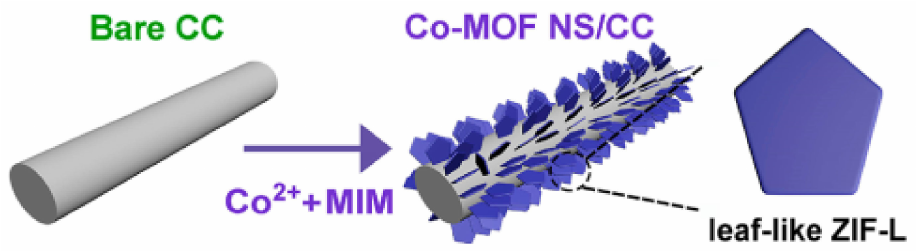
Figure 17. Schematic illustration for the fabrication of Co–MOF NS/CC. Reproduced with permission from